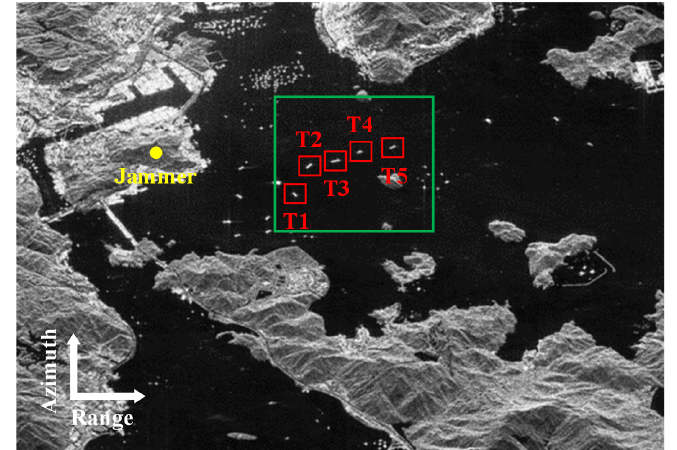
Figure 6. Ground truth.